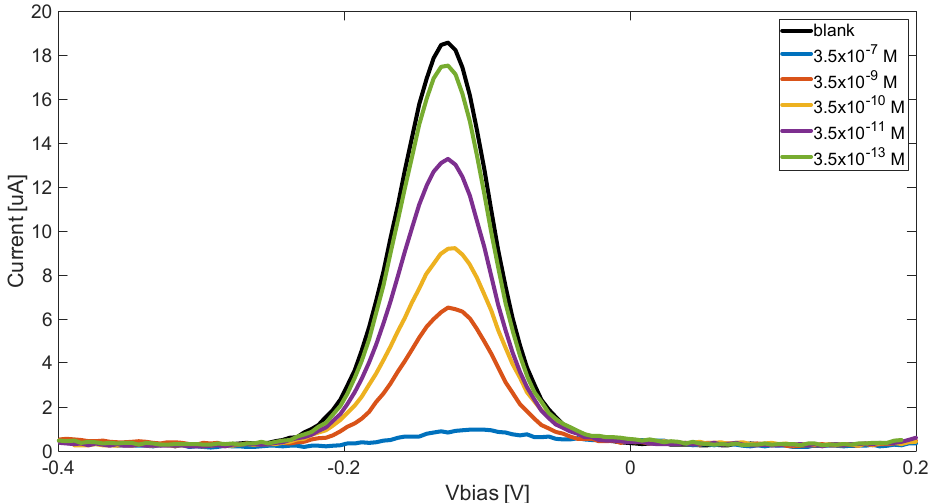
Figure 2. Differential pulse voltammetry (DPV) scans recorded carrying out immunocompetition assays over the 350 fM-350 nM HE4 concentration range in human serum samples.